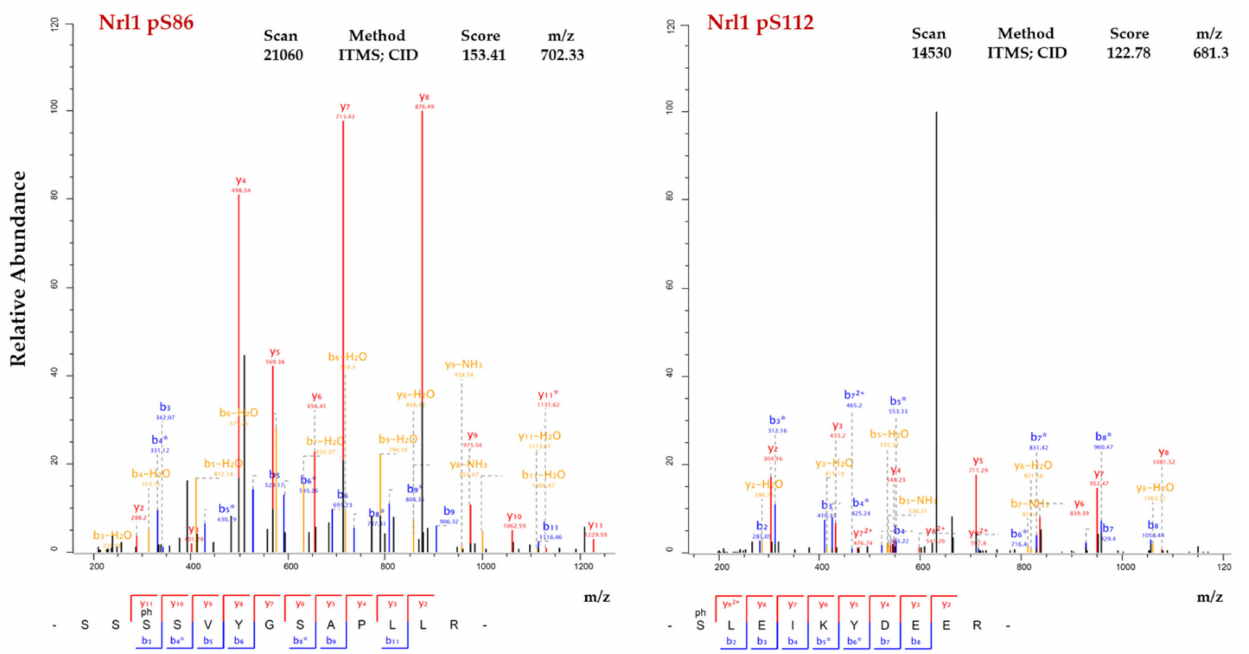
Figure 5. Fragmentation (MS/MS) spectra of newly identified Nrl1 phosphopeptides. Annotated fragmentation spectrum of a singly phosphorylated Nrl1 peptide (SSpSSVGSAPLLR) containing pS86 and a singly phosphorylated Nrl1 peptide (pSLEIKYDEER) containing pS122. Overall fragment coverage is indicated in the peptide sequences below the spectra with the b-ions in blue and y-ions in red. The asterisks in the spectra (*) denote peptide fragments with a neutral loss of H 3 O 4 P (97.98 Da) originating from the corresponding phosphorylated fragment